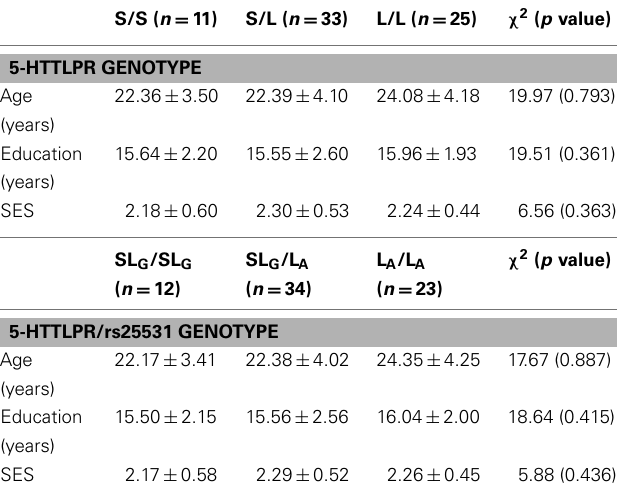
Table 2 | Demographic profiles of the 5-HTTLPR and 5-HTTLPR/sr25531 genotype